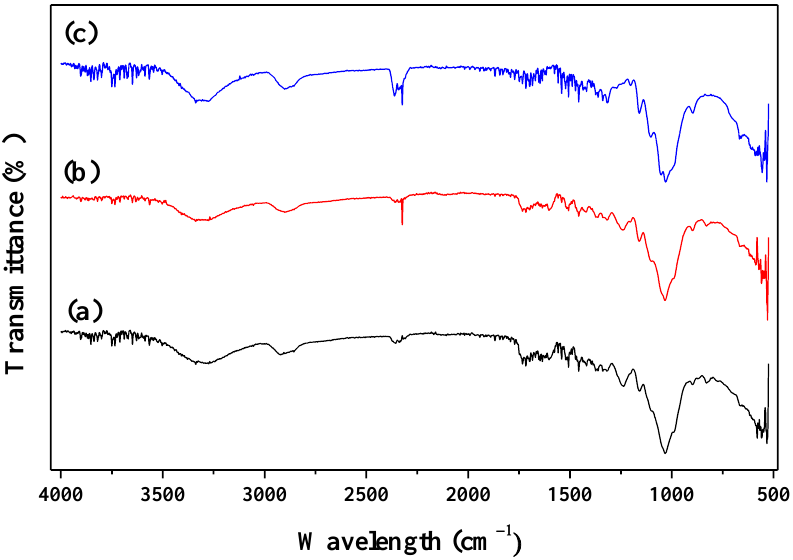
Figure 2. FTIR spectra of MC before and after adsorption of nitrate and phosphate for ( a ) MC, ( b ) MC-Nitrate, and ( c ) MC-Phosphate.